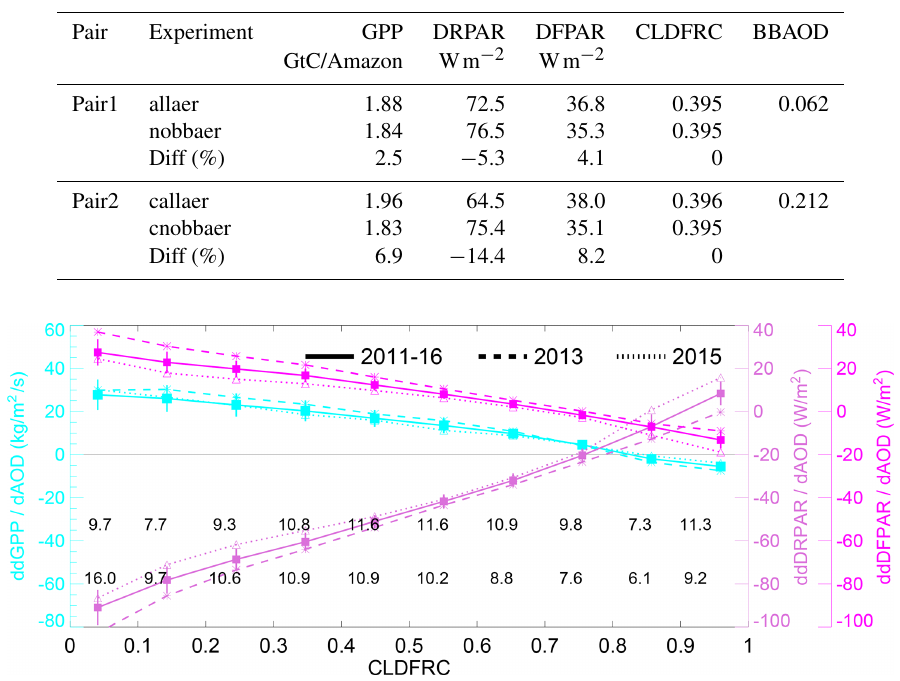
Figure 14. Radiation (DRPAR and DFPAR) and ecosystem (GPP) perturbation on every unit AOD change calculated combining the two pairs of experiments, i.e., ( dGPP 1 − dGPP 2 )/( AOD 1 − AOD 2 ) , ( dDRPAR 1 − dDRPAR 2 )/( AOD 1 − AOD 2 ) , and ( dDFPAR 1 − dDFPAR 2 )/( AOD 1 − AOD 2 ) ; here subscripts refer to the experiments of pair1 and pari2. These changes are sorted based on the values of the grid box cloud fraction on a daily basis during the reported timeframe (e.g., solid line for August–September 2011–2016, dashed line for August–September 2013, and dotted line for August–September 2015). Also shown are the vertical bars for 1 standard deviation and the number of the occurrence frequency in percent of each cloud fraction bin (0.1 increment) over the Amazon region for 2013 (first row) and 2015 (second